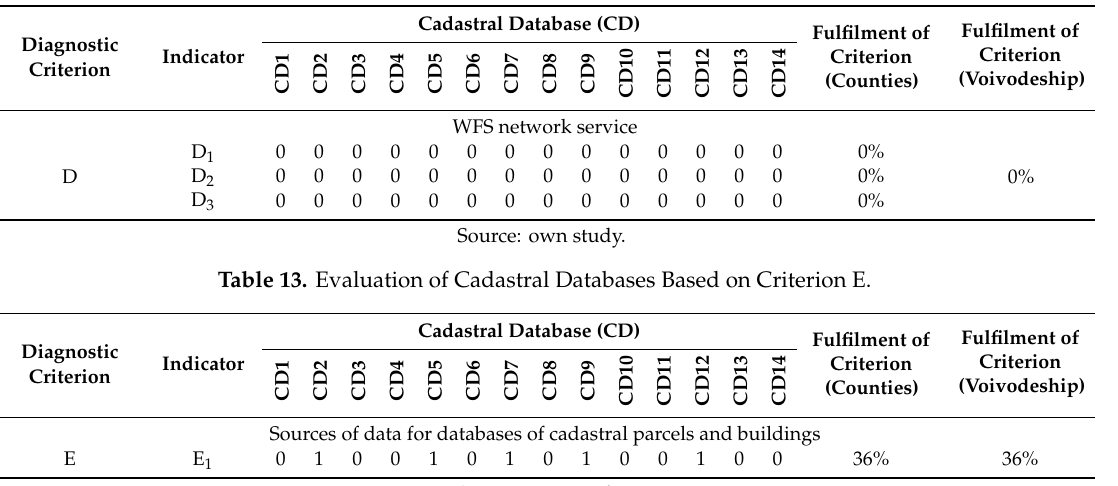
Table 12. Evaluation of Cadastral Databases Based on Criterion D.